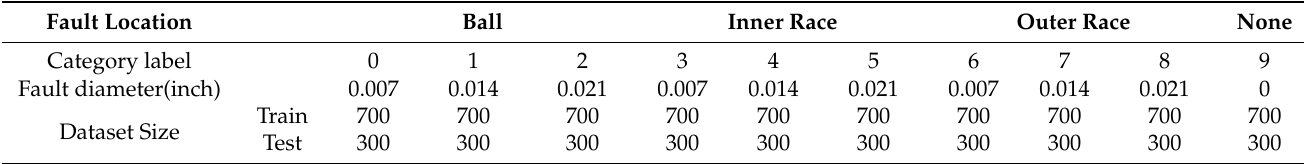
Table 2. Description of rolling element bearing datasets.